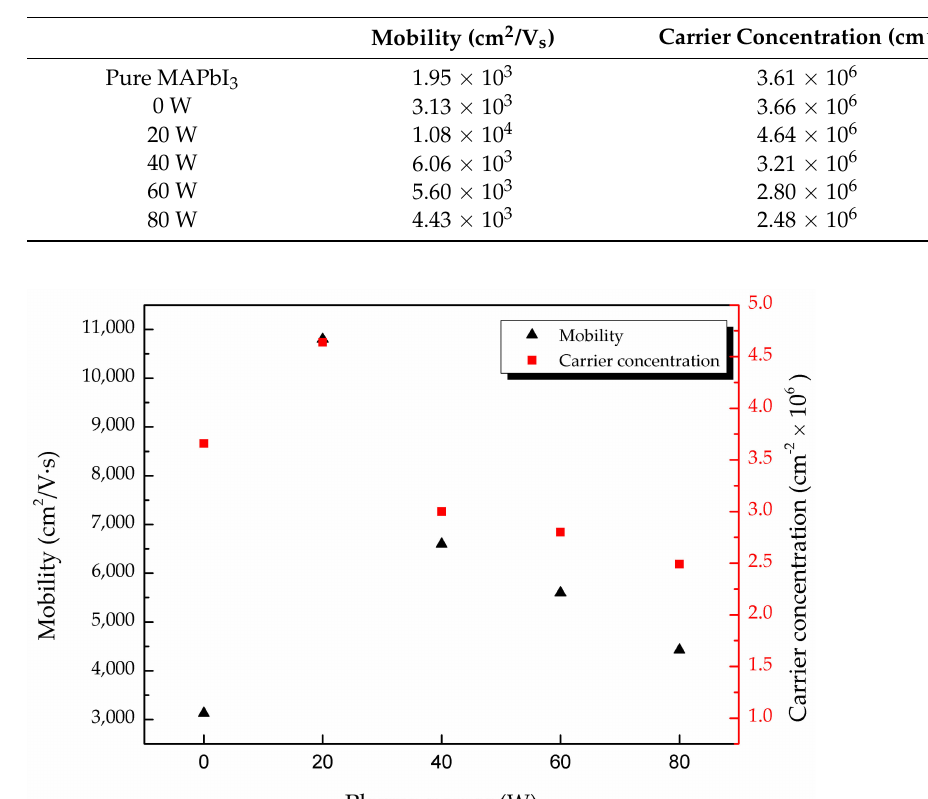
Table 1. Hall effect measurement of the pure MAPbI 3 film and MAPbI 3 film with CsPbI 3 QDs treated with oxygen plasma at 0 to 80 W coated onto a glass substrate.